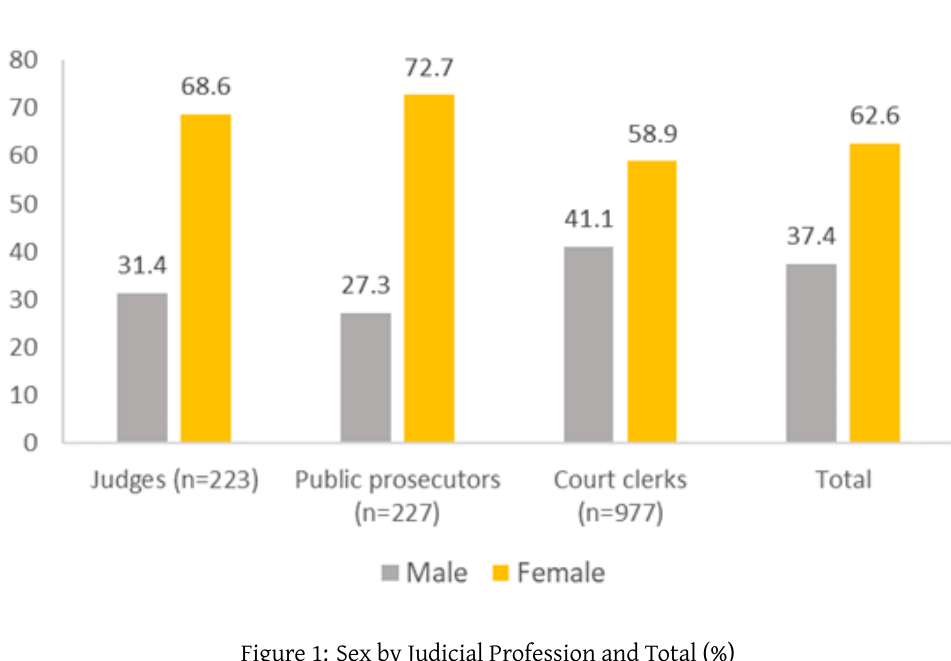
Figure 1: Sex by Judicial Profession and Total